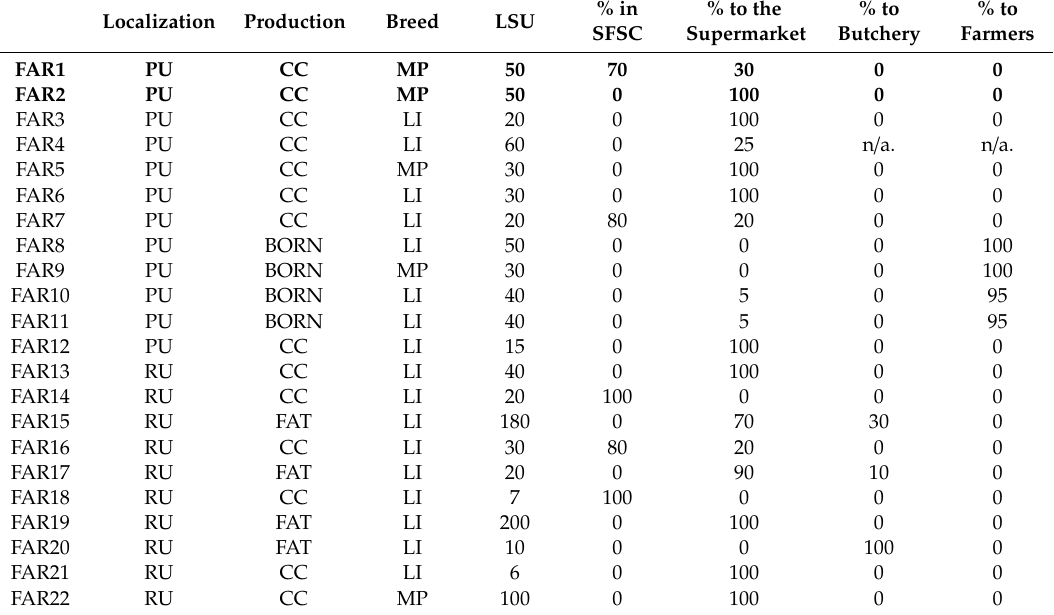
Table 2. Characteristics of farmers participating in the Carne Bovina di Pisa label in 2018 (Source: own survey to APA). PU refers to peri-urban area, RU refers to rural areas, CC refers to complete cycle, FAT refers to the farms that only do the fattening, BORN refers to the farms that only give birth to the animals, LI refers to the Limousine breed, MP refers to the Mucca Pisana breed, LSU refers to the livestock unit; SFSC refers to the sale in short food supply chains; and n / a., not available. In bold, the farms surveyed in 2013 and 2018.